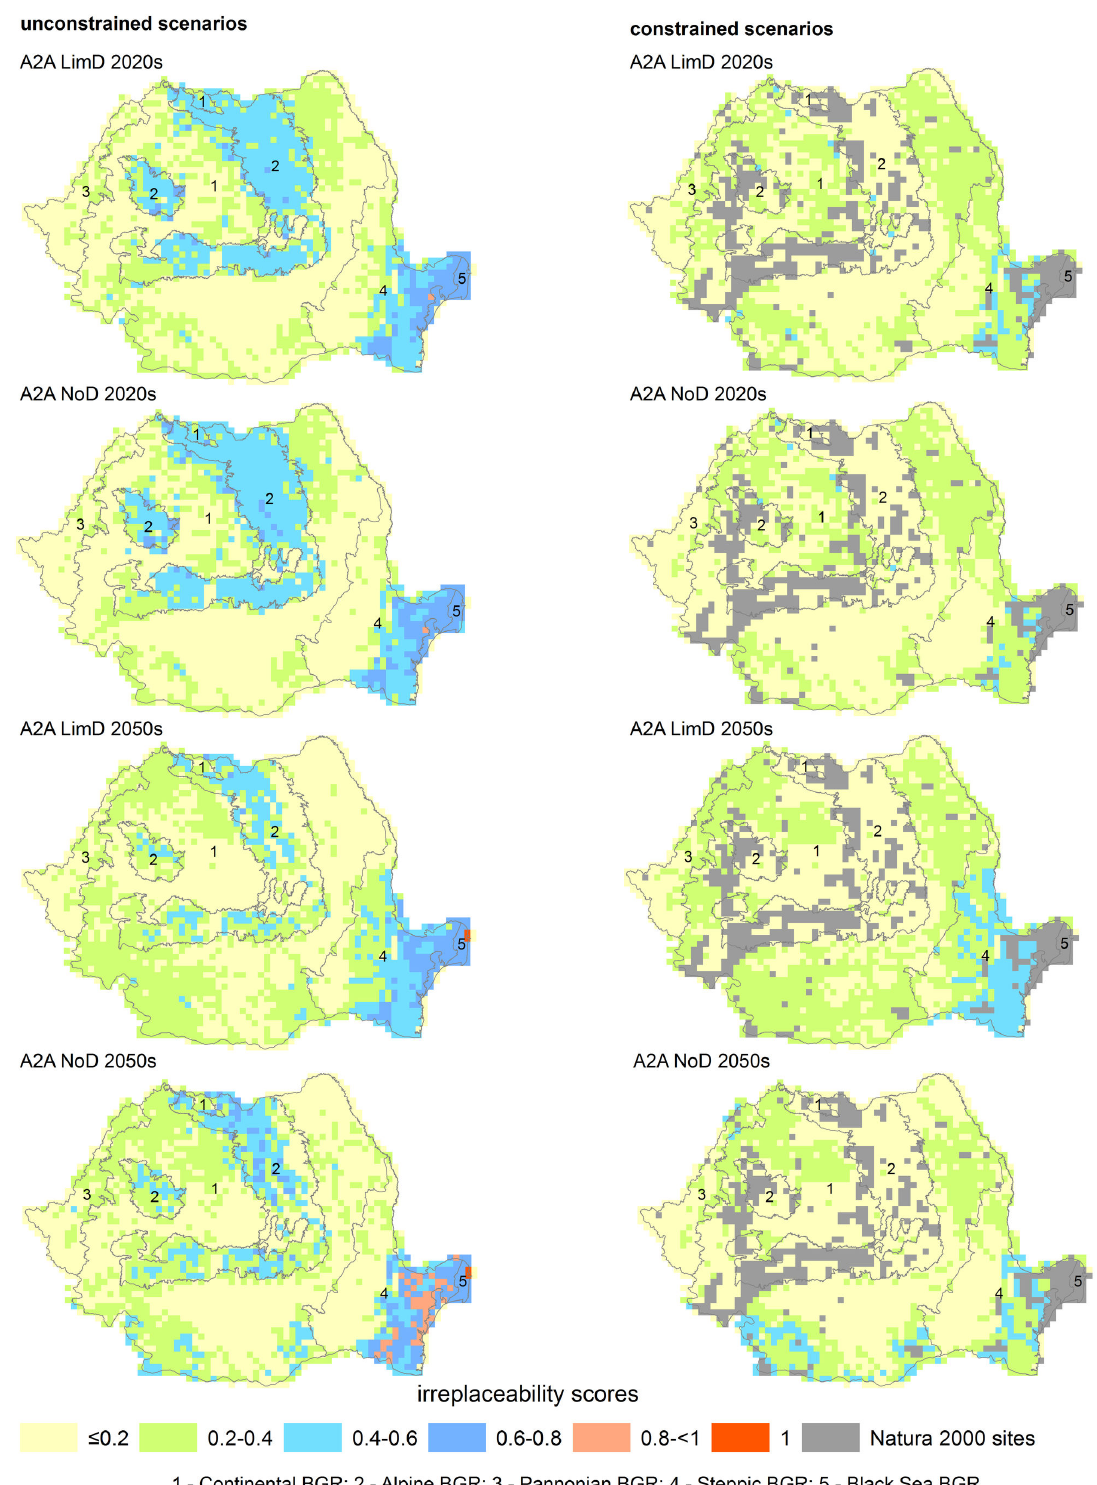
Figure 5. Example future irreplaceability scores (emission scenario A2A) under constrained (left panels) and unconstrained (right panels) planning unit availability for the 2020s and 2050s time horizons and three emission scenarios, under limited (LimD) and no dispersal (NoD) assumptions.